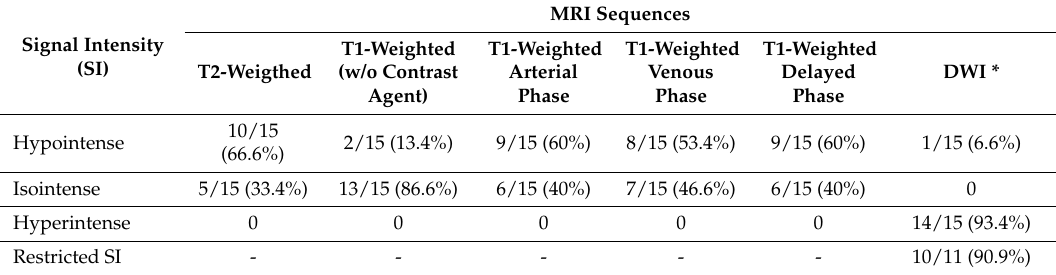
Table 2. Signal intensity (SI) at MRI for single and/or multiple focal kidney lesions, compared to the surrounding normal